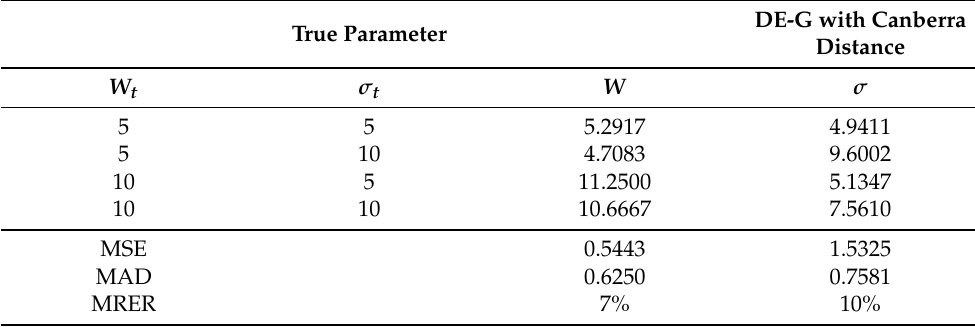
Table 5. Combined noise parameters’